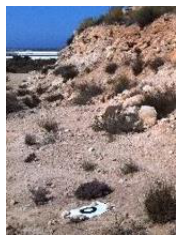
Figure 3. A4 size target point materializing control points and check points